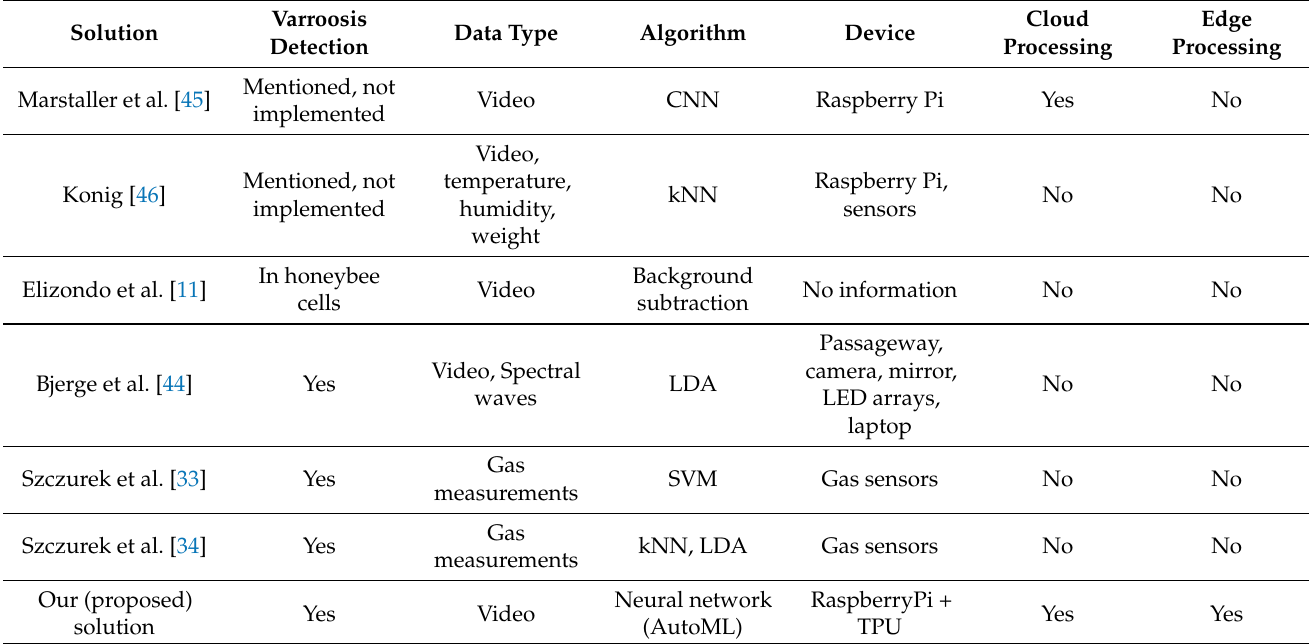
Table 5. Comparison of bee monitoring solutions, including detection of the Varroa destructor